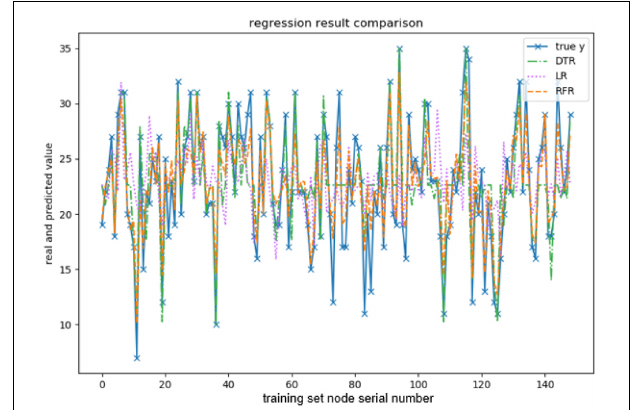
FIGURE 3 | Comparison of openness predicted values.